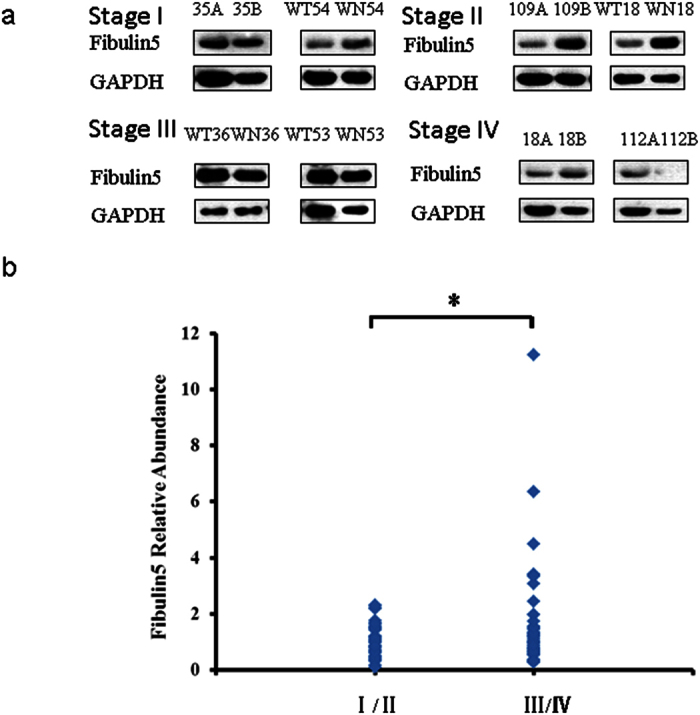
Validation of Fibulin-5 expression by Western Blot.(a) Representative Western Blot image of Fibulin-5 expression in stages I–IV GC samples (A or WT. cancer, B or WN. normal gastric tissue). The blots were cropped image and full length blots are presented in Supplementary Figure S4. (b) Fibulin-5 relative abundance in 97 GC samples. *P < 0.05.